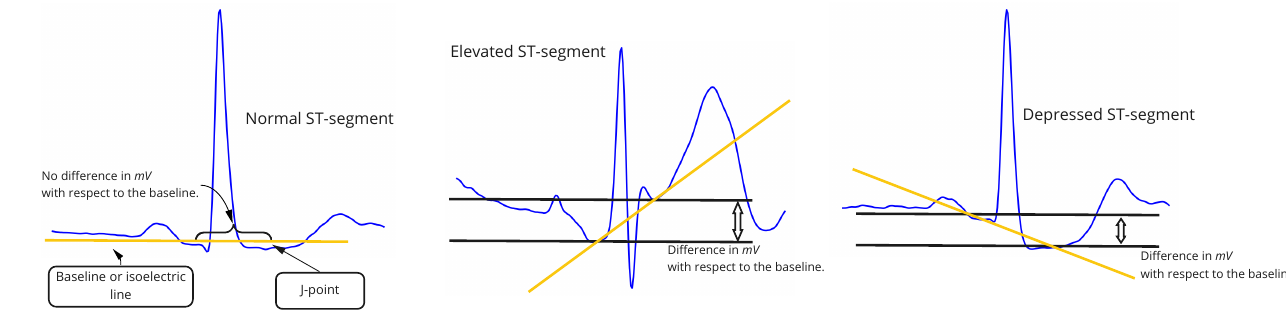
Figure 2. ST-segment deviation visual, the traditional way to identify this abnormality by measuring the distance between the ST-segment and the isoelectric line. Normal ECG beat ( left ), elevated ST-segment ( center ), depressed ST-segment ( right